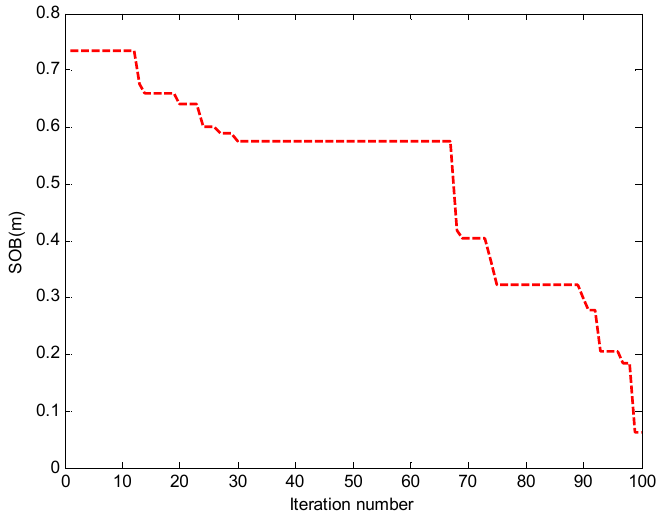
Figure 7. Optimized SOB using a genetic algorithm versus iteration number.